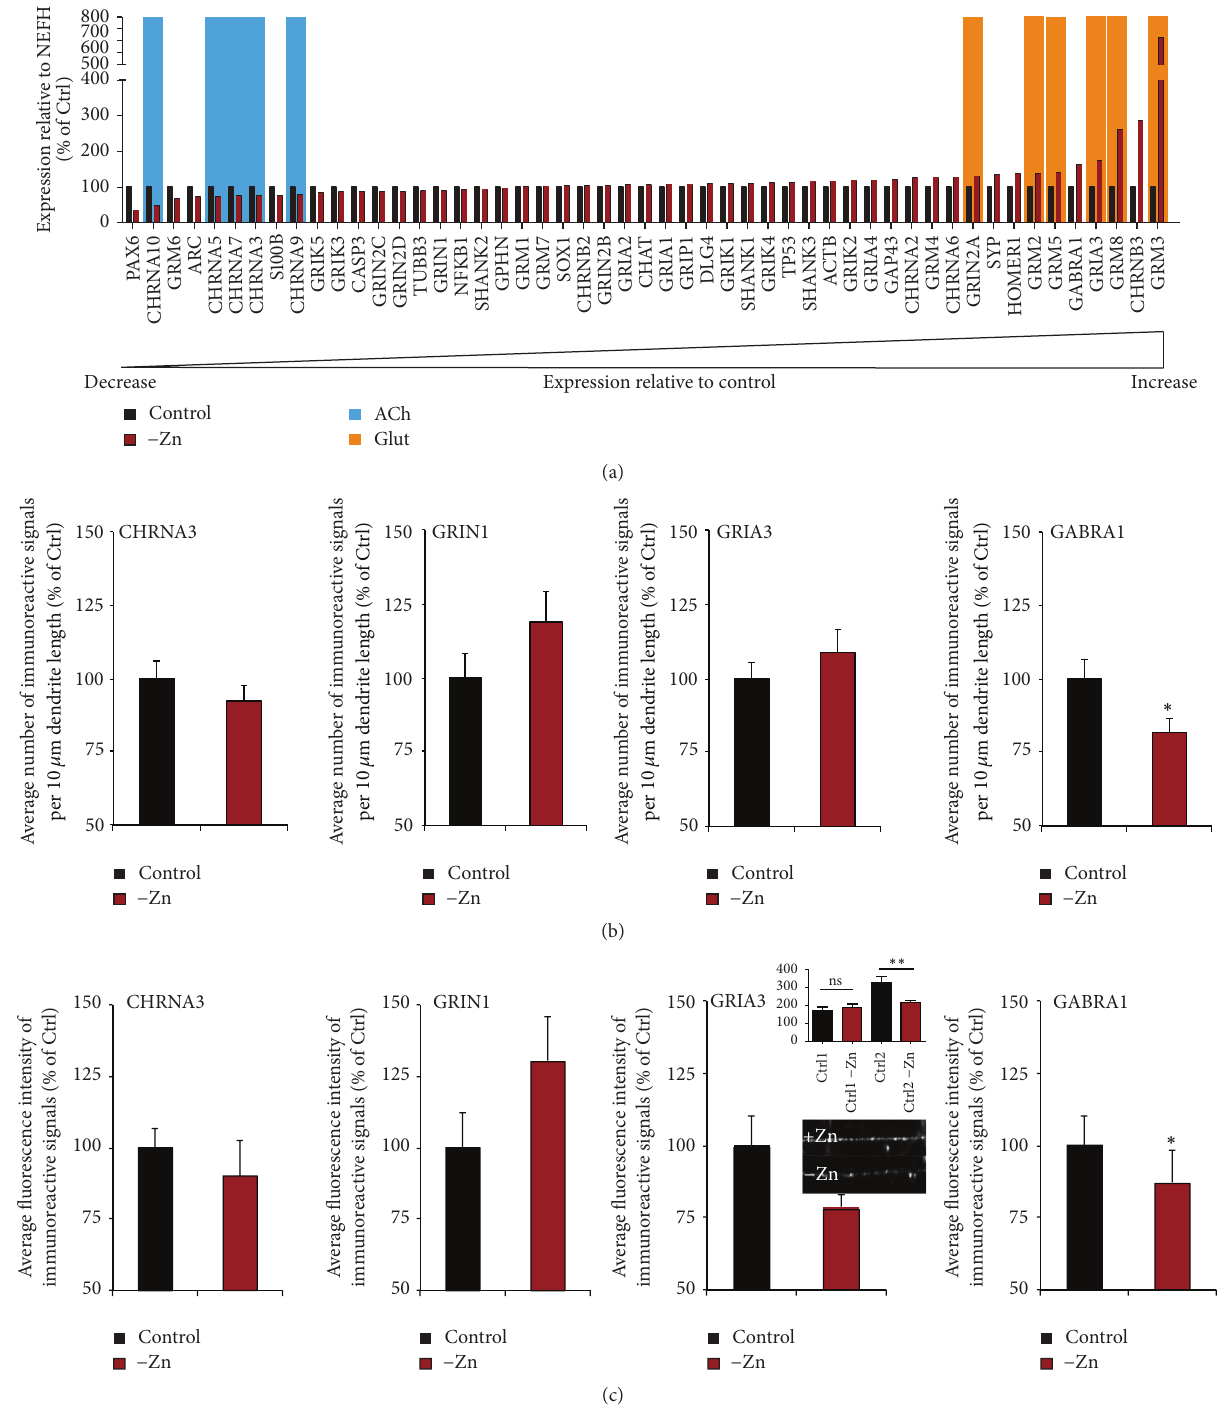
Figure 5: Cells differentiated under different zinc levels show altered gene expression and protein levels of neurotransmitter receptors. (a) A screening for the expression of genes associated with glutamatergic and cholinergic neurotransmission as well as synapse plasticity reveals a decrease of ACh receptors, mainly CHRNA3, CHRNA5, CHRNA7, CHRNA9, and CHRNA10, while an increase in glutamate receptor expression (GRM2, GRM3, and GRM5; GRIA3; GRIN2A) was observed. (b) Immunocytochemical analysis of 𝑛 = 20 cells per condition. The mean number of signals per dendrite length was assessed. No differences were detected for CHRNA3, GRIN1, and GRIA3. A significant reduction was seen for GABRA1 signals ( 𝑡 -test, 𝑝 = 0.05 ). (c) Immunocytochemical analysis of 𝑛 = 20 cells per condition. The mean signal intensity per fluorescent puncta was assessed. No differences were detected for CHRNA3 and GRIN1. A significant reduction of GABRA1 signal intensity ( 𝑡 -test, 𝑝 = 0.022 ) was observed. GRIA3 signal intensity was reduced only in one cell line ( 𝑡 -test, 𝑝 = 0.0045 ). ns: not significant. ∗ 𝑝 ≤ 0.05 ; ∗∗ 𝑝 ≤ 0.01